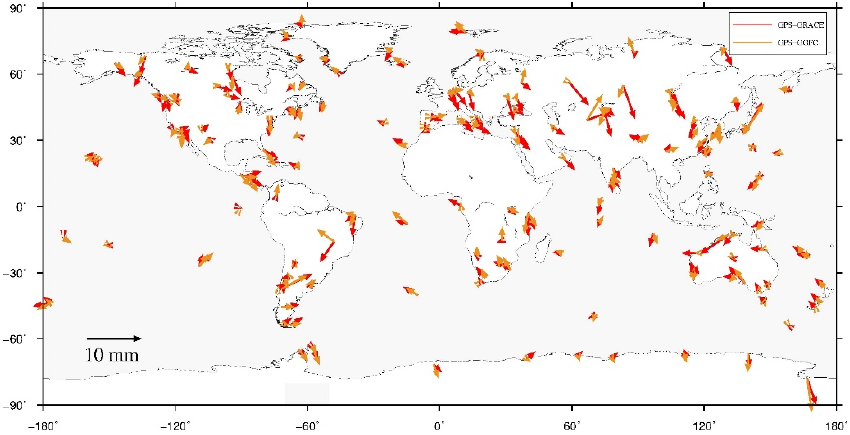
Figure 3. Harmonic annual VD derived from GNSS monthly time series after removing the GRACE (red) and GGFC (yellow) modeled VD. The length of the vector represents the seasonal amplitude, and the vector direction points directly to the direction of the initial phase angles.